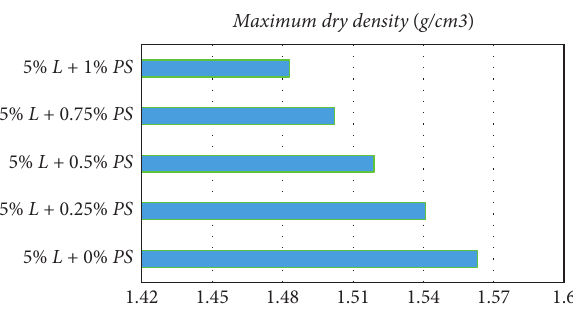
Figure 5: Variation of unconfined compressive strength with plastic strip